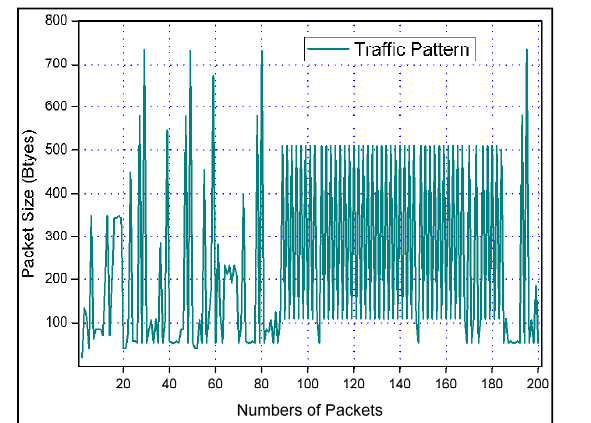
Fig. 10: NEST Smoke Alarm Traffic Pattern